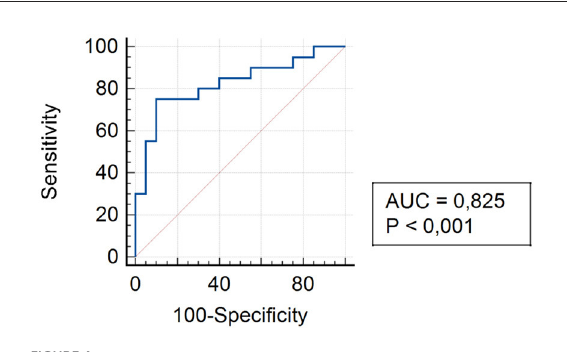
FIGURE4 ROC curve for TLR4 expression in patients of Group I 3 and 6 months after surgery.